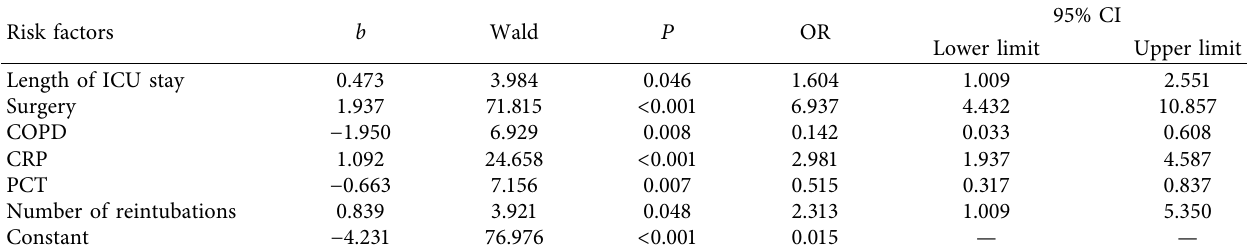
Table 2: Multivariate analysis of VAP risk in elderly ICU patients on MV.